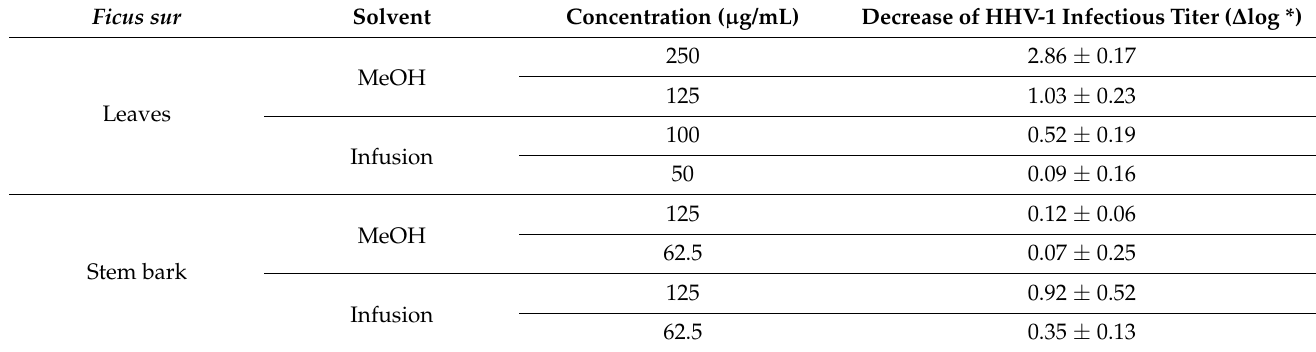
Table 6. Abatement of HHV-1 infectious titer in response to Ficus sur